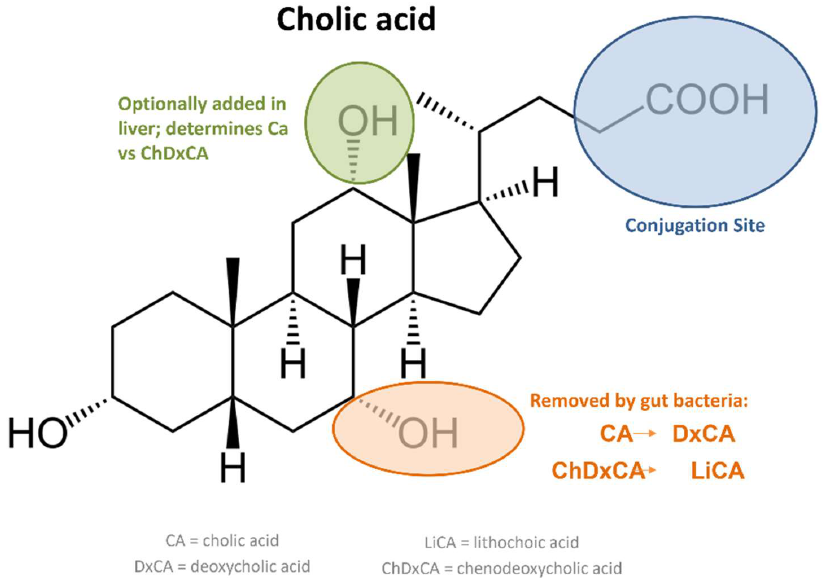
Figure 4. Structure of cholic acid, a primary bile acid, displaying the radicals susceptible to the action of gut